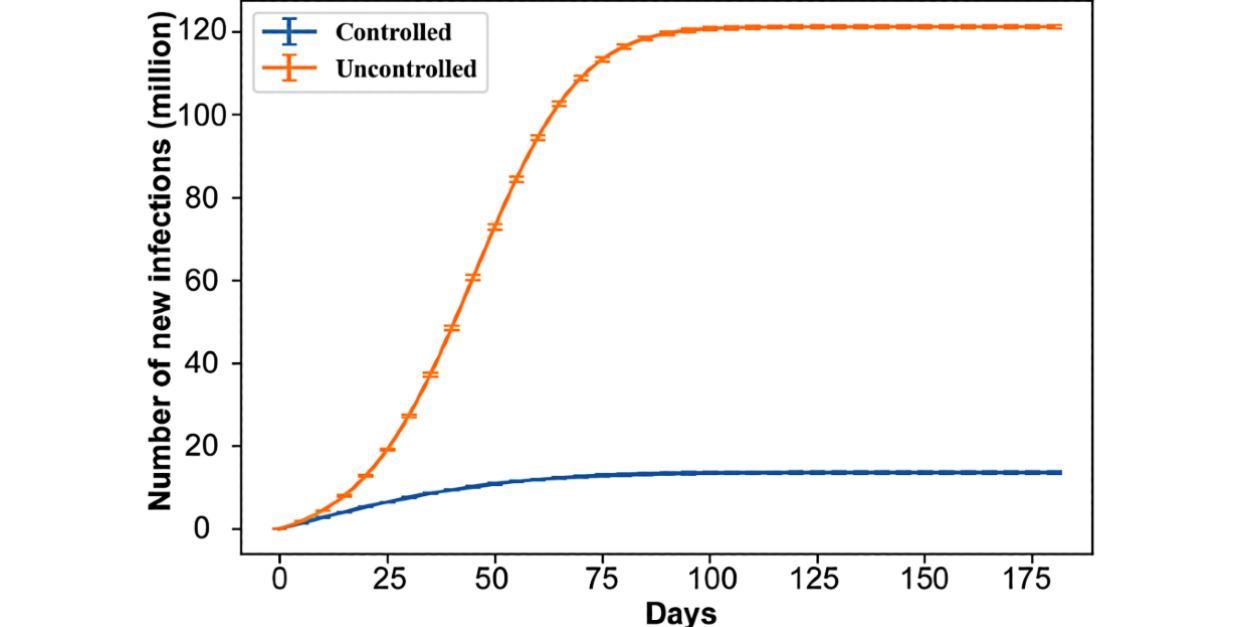
Figure 5. Number of new infections during the simulation (ie, cumulative cases) under Operation Warp Speed with vaccine compliance of 0.6, vaccine efficacy of 0.99, scenario 1 for nonpharmaceutical interventions (“controlled” case: blue), and scenario 6 consisting of no interventions (“uncontrolled” case: